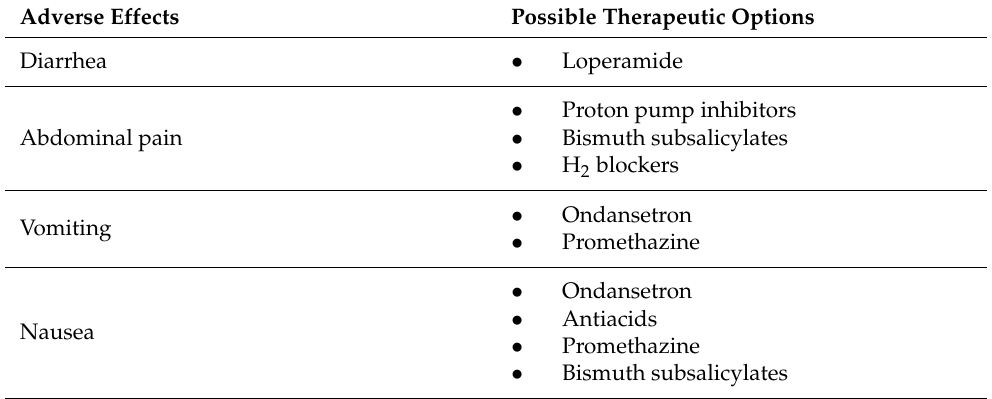
Table 1. Table with a list of the most frequent gastrointestinal adverse effects caused by DMF and possible therapeutic